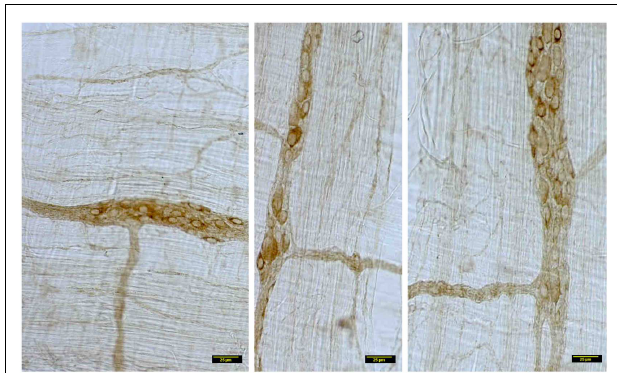
FIGURE 4 | Details of myosinVa staining of ganglionic neurons and their processes in diabetic jejunum . Note the heterogeneity of appearance of myosinVa in the cell bodies of the neurons in the myenteric plexus. In the left panel, note the moderate staining in the cell bodies of many neurons. Also note that the secondary plexus running to the left of the image has some brown DAB staining. Some of the neuromuscular varicosities have faint brown staining. In the middle panel, note the enlarged neuronal soma with unhealthy appearing nucleus, possibly indicating a degenerating neuronal cell body.The increase in size may be related to the cellular accumulation of myosinVa, possibly resulting from stasis of myosin Va axonal transport. Also note the absence of brown staining in all of the neuronal processes ramifying through the muscular wall.The right panel recapitulates information represented in the middle panel and in addition, shows a full range of neuronal cytopathology. Note that in the upper pole, two neurons do not have any cytoplasmic staining and the lower neuron is possible degenerative, as evidenced by unusual nuclear appearance. Note very scant or nearly absent staining in the interneuronal processes, secondary plexi as well as tertiary neuromuscular nerve varicosities. Also note that some cells (top right, also one cell body in the right on left panel) show intense dark brown staining.This heterogeneous appearance may result from enhanced myosinVa transcription but may have also resulted from myosinVa aggresome formation. Scale bar, 25 µ